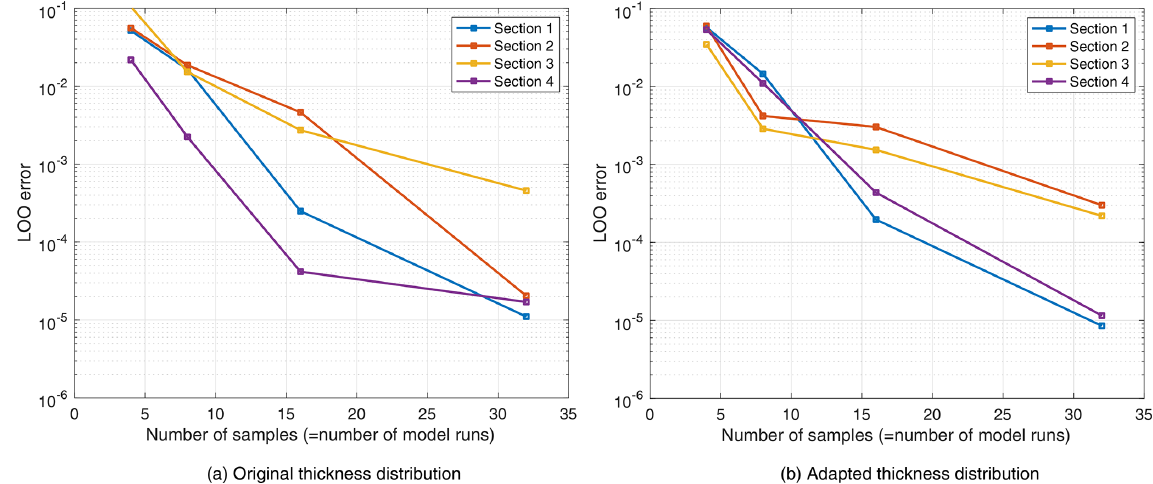
Figure B1. Convergence of LOO error as function of number of samples for DANAERO test case with 12 parameters. Each data point corresponds to the average over five runs. (a) Original thickness distribution. (b) Adapted thickness distribution.